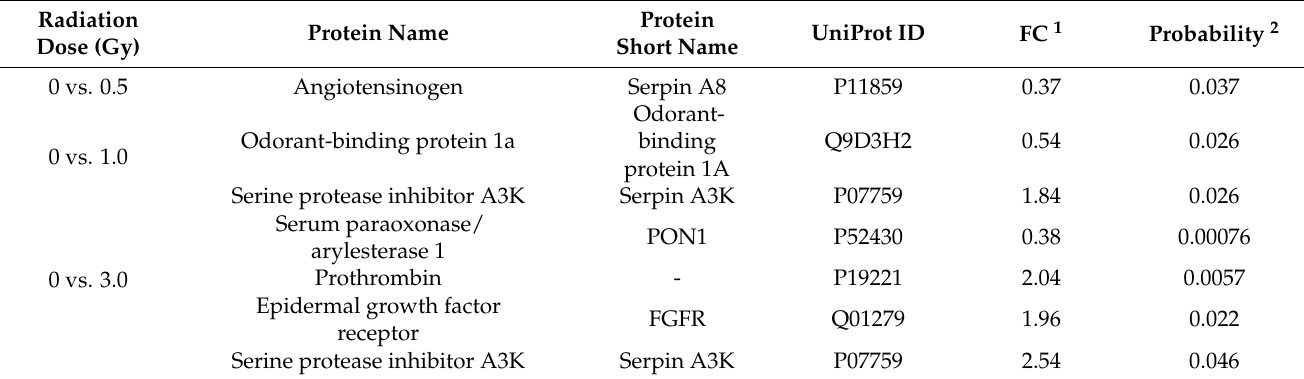
Table 1. Proteins that varied significantly according to the dose of